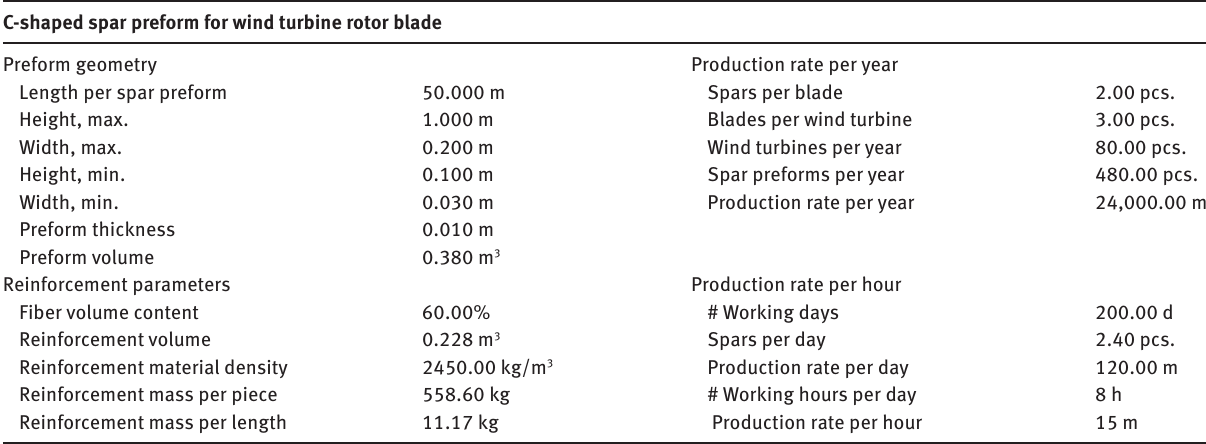
Table 2: Parameter list for an application scenario for automated manufacturing of C-shaped spar preforms. C-shaped spar preform for wind turbine rotor